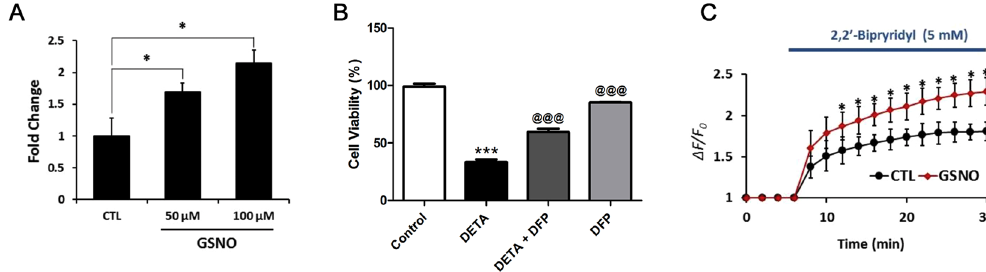
Figure 2. NO treatment induces iron uptake in retinal cultures and purified RGCs. Dissociated primary pan- retinal ( A , B ) and immunopurified RGC ( C ) cultures were prepared from neonatal day 4–5 C57BL/6J mice. ( A ) 1 hr incubation with the NO-donor GSNO induces iron uptake, measured as the presence of ascorbate- 55 Fe 2 + ( * p < 0.05). ( B ) 24 h treatment with NO-donor DETA-NONOate (200 μ M) increases retinal cell death ( *** p < 0.001) compared with control cultures. Treatment with 200 µ M deferiprone for 24 h significantly ( @@@ p < 0.001 compared with DETA-NONOate treatment alone) attenuates retinal cell death induced by DETA- NONOate. Deferiprone treatment alone (without DETA-NONOate) does not affect retinal cell survival, with no difference in cell viability compared to control cultures, and viability remains significantly higher than in cultures treated with DETA-NONOate alone ( @@@ p < 0.001). ( C ) Purified RGCs were incubated with GSNO, then intracellular iron levels were detected with iron-sensitive dye, Phen-GreenSK (PG SK) and 2,2 ′ -bipyridyl (BPD). 2,2 ′ -BPD chelates intracellular iron, increasing PG SK fluorescence. RGCs treated with GSNO show increased intracellular iron levels compared with control RGCs ( * p < 0.05, N = 20 cells/treatment group). The normalized change of fluorescence ( Δ F / F ) was used to estimate change in cytosolic Fe 2 + levels. All experiments were repeated 3